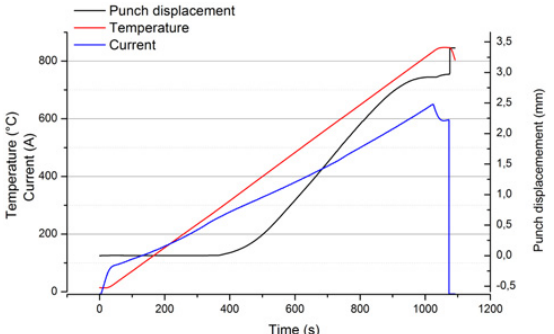
Fig. 5. Displacement, heating rate and current delivery during